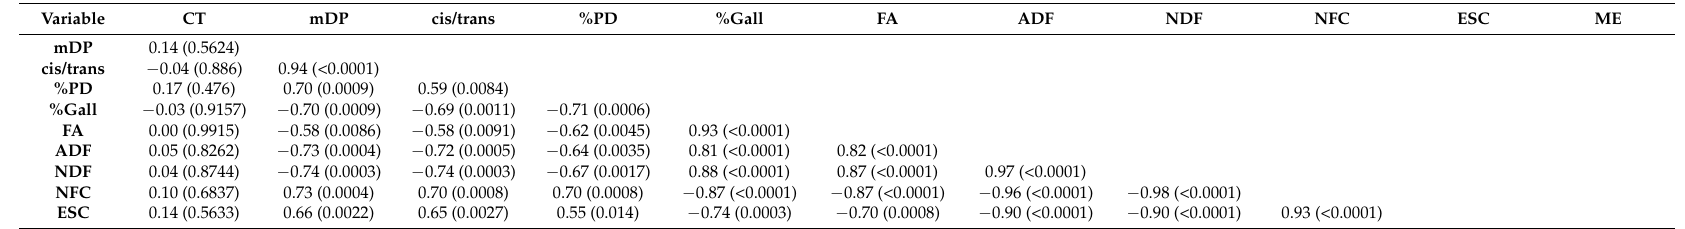
Table 6. Pearson correlation coefficients (r) for grape marc compositional variables, with p -value shown in parentheses, using data for twenty grape marc samples taken from Hixson et al., 2016 and re-assessed to give correlations within the sample